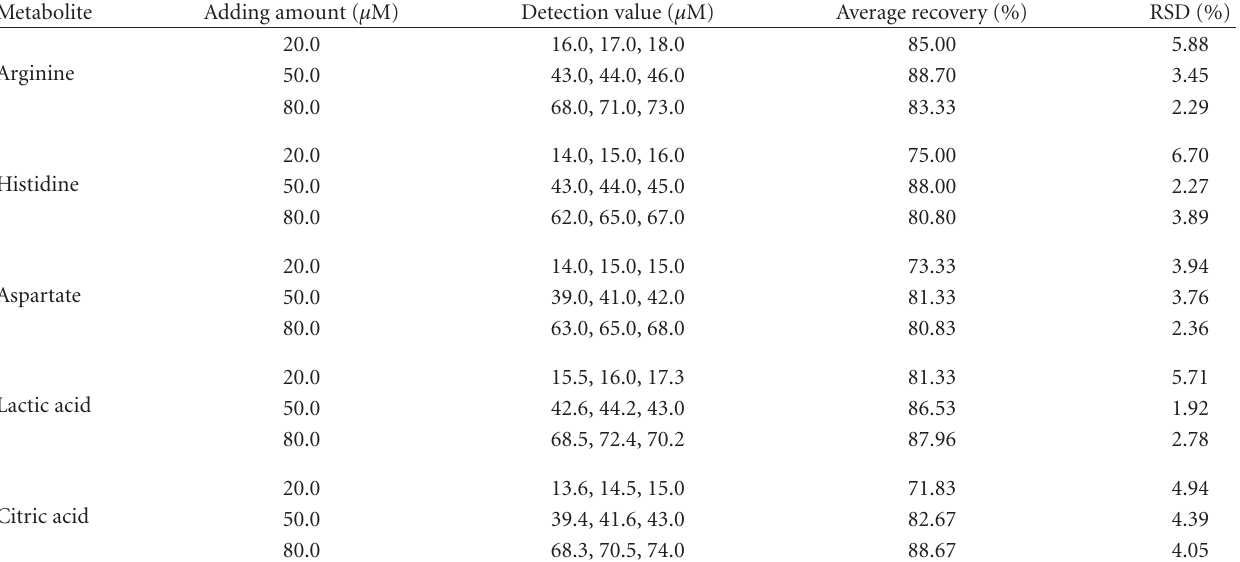
Table 1: Recoveries and precision of QC samples ( n =